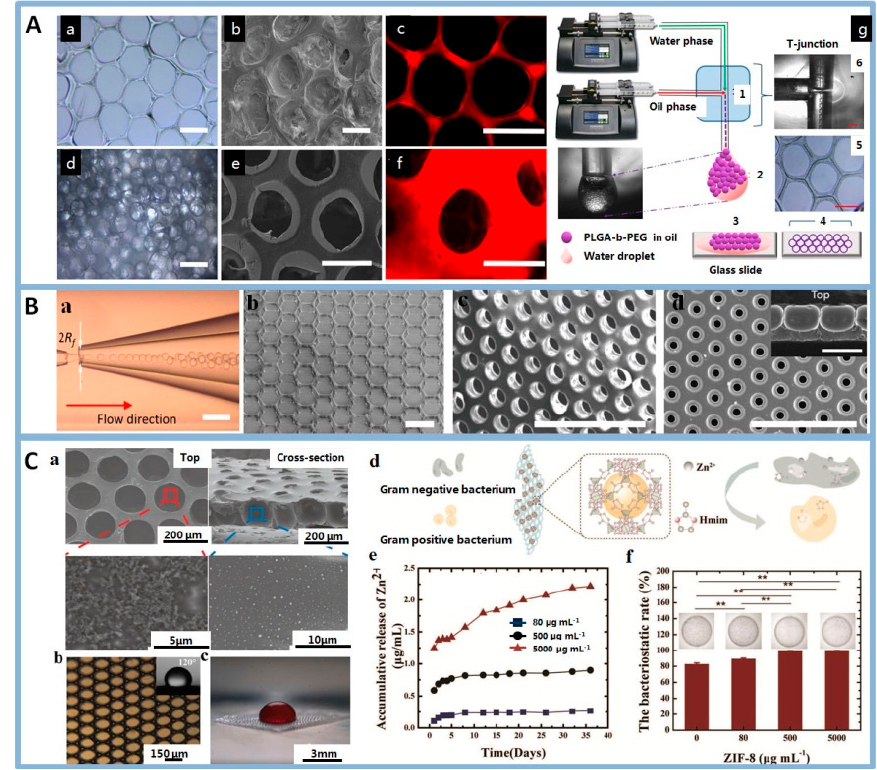
Figure 7. ( A ): Optical micrographs (a,d), SEM (b,e), and fluorescent microscopes (c,f) of honeycomb-like structures, (g) schematic preparation process of sca ff olds with T-junction microfluidic device, scale bars indicate 100 µ m (a,b,d,e), 200 µ m (c), and 400 µ m (f). Reprinted from [28] with permission. Copyright 2018 American Chemical Society. ( B ): (a) micrographs of microfluidic devices used for the generation of droplets, monolayer film of (b) the cage, (c) through-pore, and (d) dead-end pore structure of the film. Reprinted from [30] with permission. Copyright 2018 Wiley. ( C ): (a) SEM images showing the porous structure from a top view and a cross-sectional view, and ZIF-8 inside the membranes, (b) microscopic optical image of the membrane with uniform pores, (c) optical image showing a drop of blood on the porous membrane, (d) schematic diagrams for the antimicrobial mechanism of ZIF-8 hydrogel membranes, (e) The zinc-ions release of the ZIF-8-laden membranes with di ff erent ZIF-8 concentrations during 36 days, (f) The statistical graph of the bacteriostatic rate of the membranes at di ff erent ZIF-8-laden concentrations. Reprinted from [84] with permission. Copyright 2020